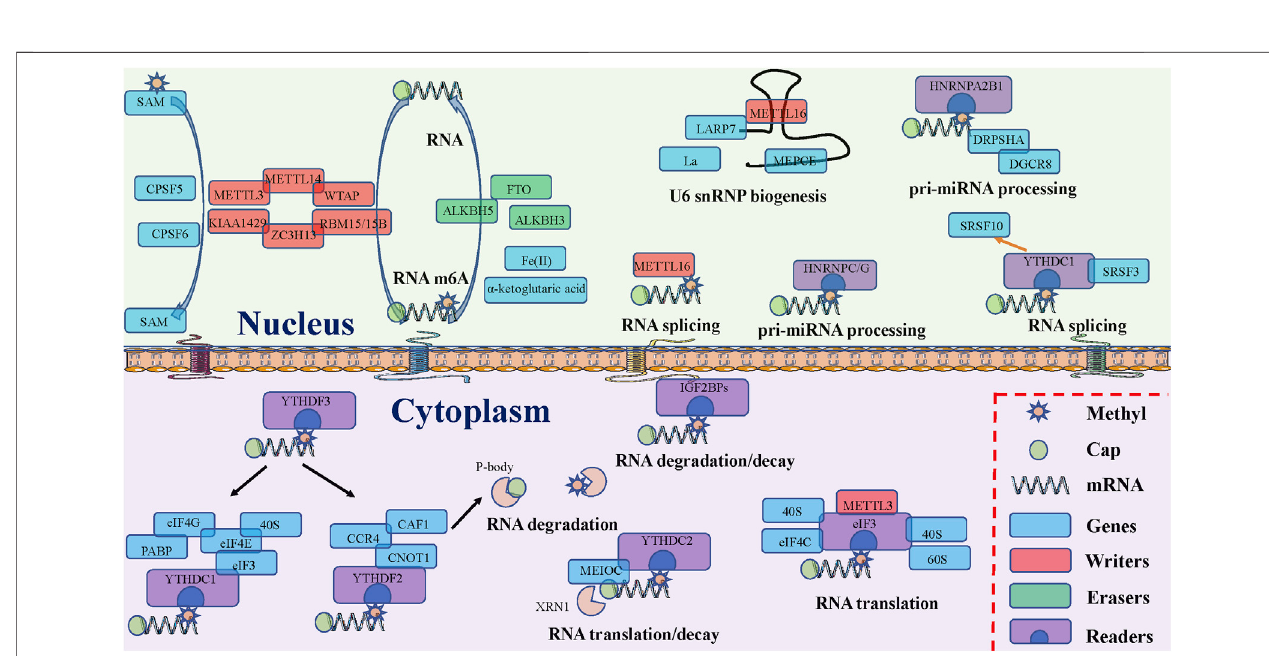
FIGURE 2 | The potential functions of RNA m6A modi fi cation related proteins. “ Writers, ” “ Erasers ” , and “ Readers ” rely on several crucial factors to install, remove, and recognize m6A modi fi cations and participate in various RNA metabolism steps, including splicing, export, translation, degradation, and decay.